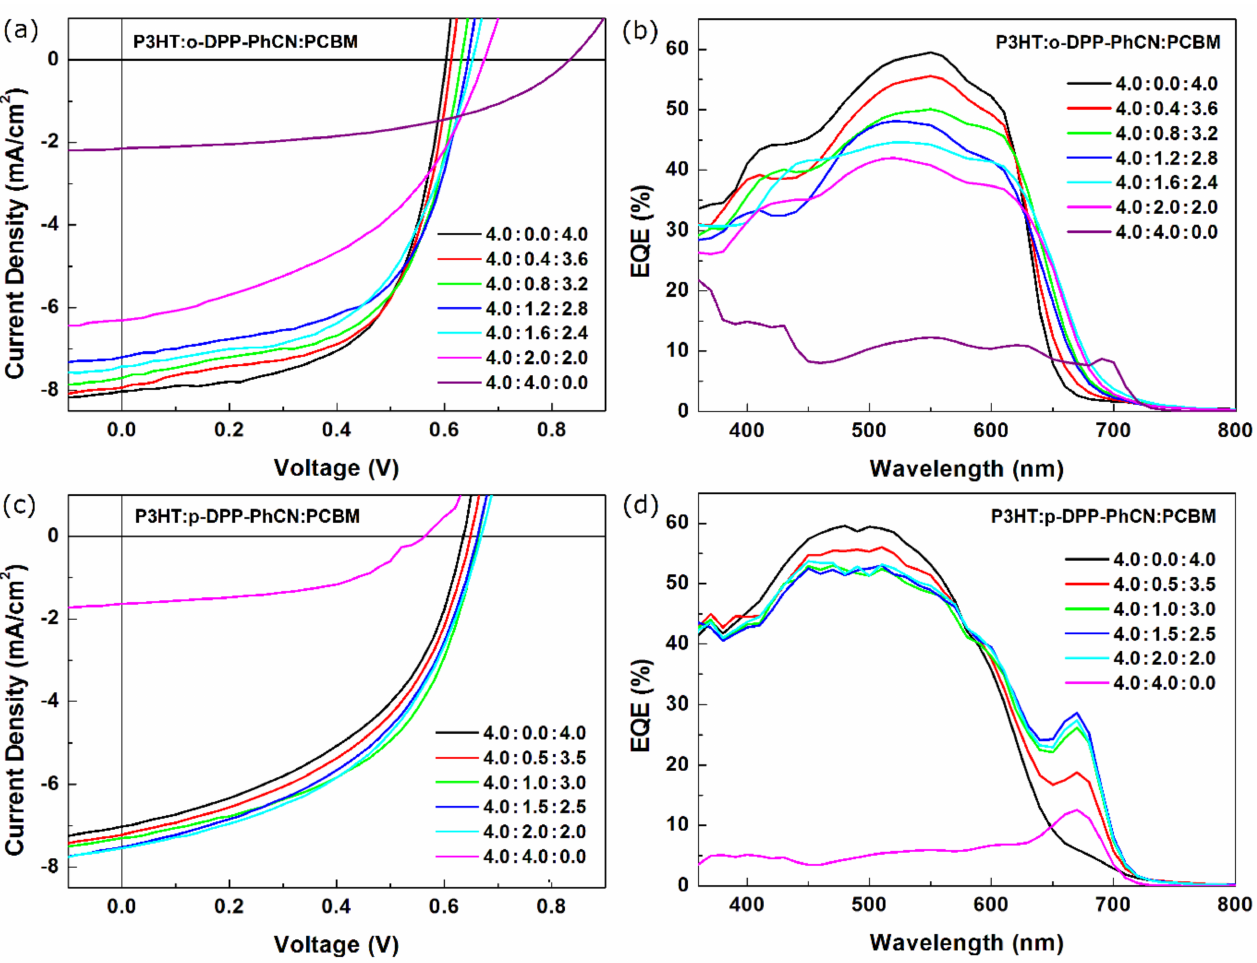
Figure 4. ( a , c ) Density vs. voltage ( J - V ) and ( b , d ) EQE curves of the ternary devices fabricated with various blend ratios of P3HT: o -DPP-PhCN:PCBM and P3HT: p